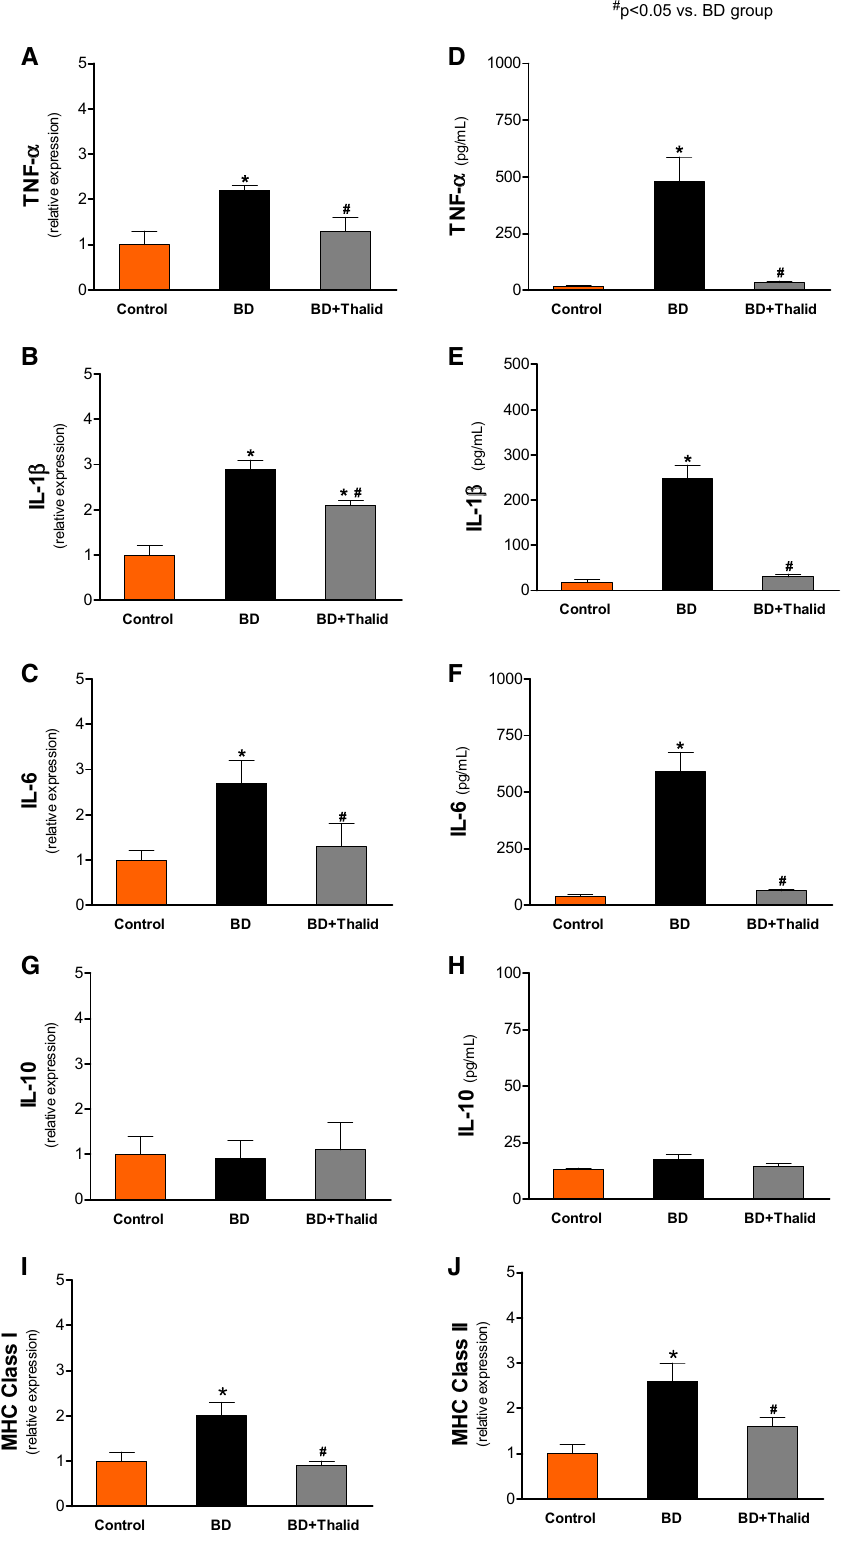
Figure 4. Comparative analysis of inflammatory cytokines 6 h after brain death in the different groups. The expression of TNF-α ( A ), IL-1β ( B ), IL-6 ( C ), IL-10 ( D ), ( I ) MHC Class I and ( J ) MHC Class II was analysed by real-time RT–PCR in liver tissue. The cytokine levels of TNF-α ( E ), IL-1β ( F ), IL-6 ( G ), and IL-10 ( H ) were measured using a MILLIPLEX/LUMINEX MAP